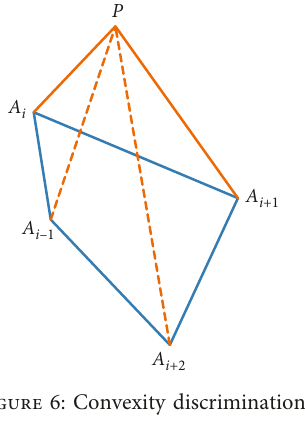
Figure 6: Convexity discrimination.